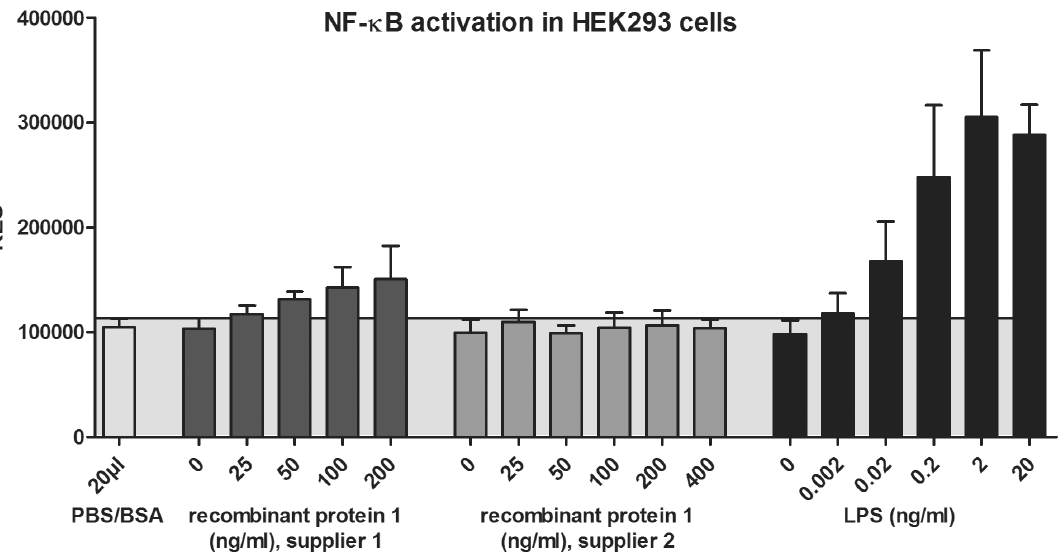
Figure 2. Activation of NF- k B by endotoxin impurities in commercial preparations of a recombinant protein. NF- k B activation in HEK293 cells transfected with an NF- k B luciferase reporter plasmid and plasmids encoding LPS-receptor components (TLR4, CD14, MD-2) is shown. Cells were exposed to recombinant protein 1 from supplier 1 or 2, LPS, or solvent, in the amounts stated. 20 h after induction, luciferase activity was measured. Results show mean and standard deviations of four independent experiments.